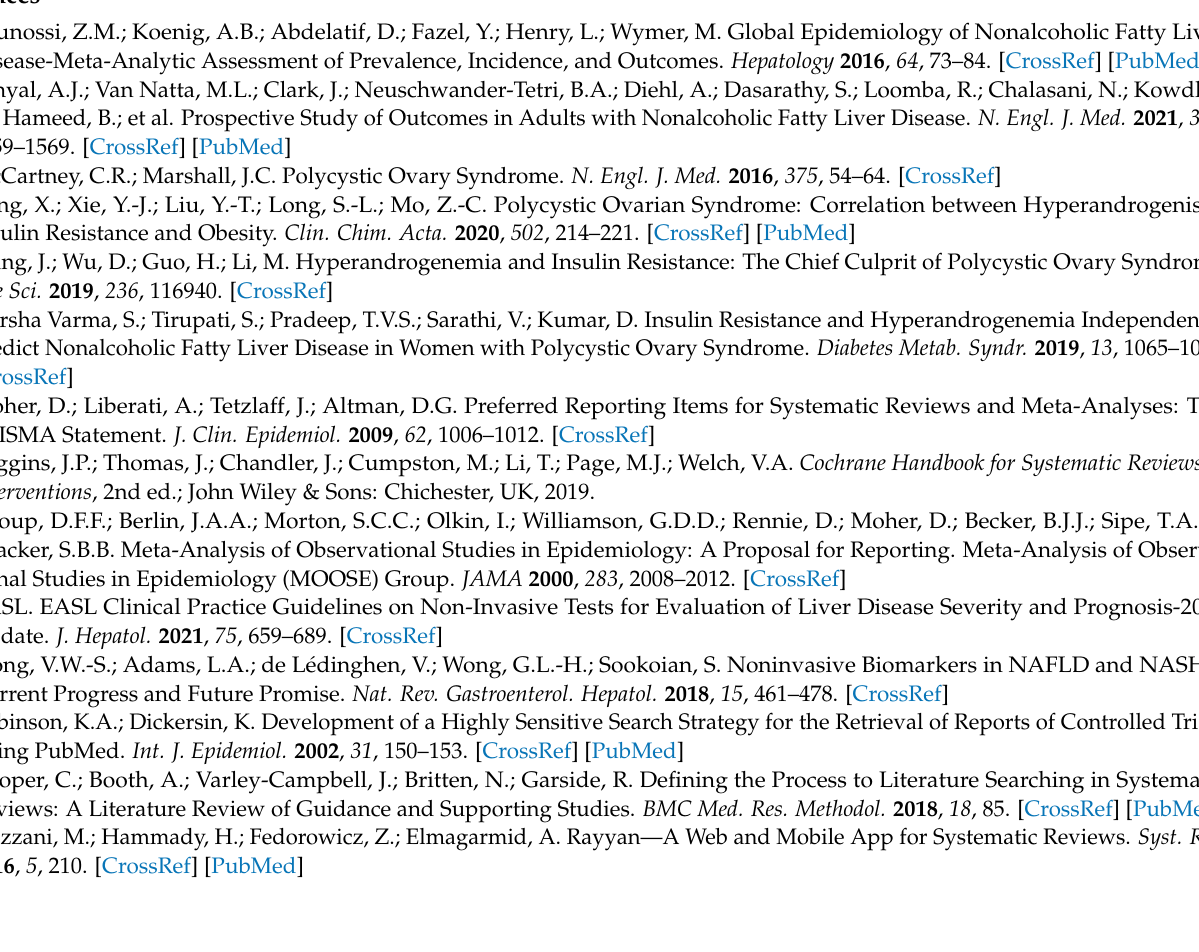
studies: Figure S1. Risk of bias evaluation according to MINORS, 3. Table S1. Objectives, inclusion, and exclusion criteria from each study, 4. Table S2. Definitions and cut-off values used to